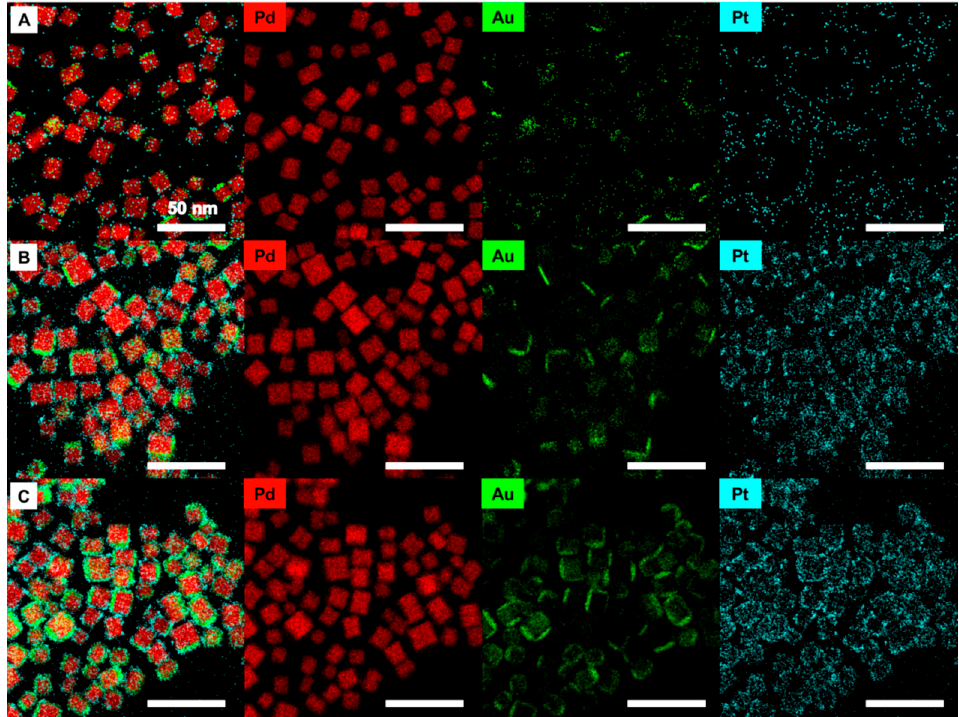
Figure 3. Low-magnification EDS images of AuPt@Pd nanoparticles synthesized with varying Au and Pt mol% ratios. The mol% of Au:Pt were ( A ) 2:1, ( B ) 5:2.5, and ( C ) 25:5.